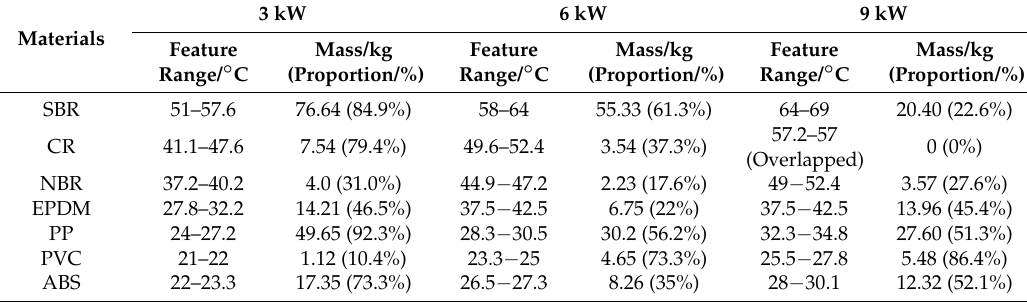
Table 2. Feature temperature ranges corresponding to the tested polymer